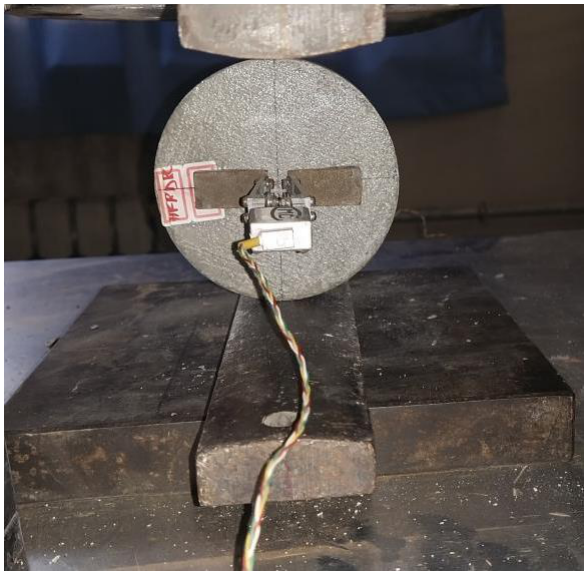
Figure 5. Splitting tensile test.